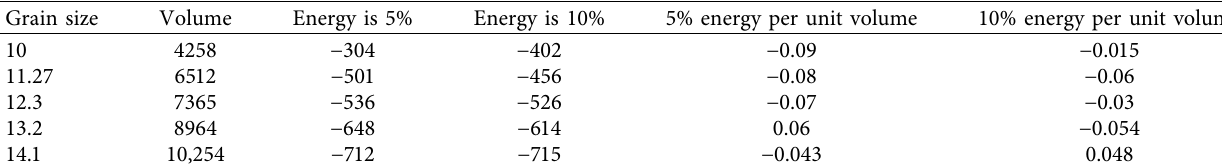
Table 3: Matrix action energy.